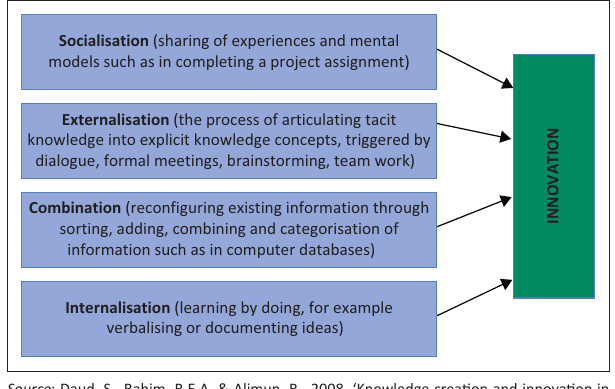
FIGURE 1: SECI Model: Innovation in selected